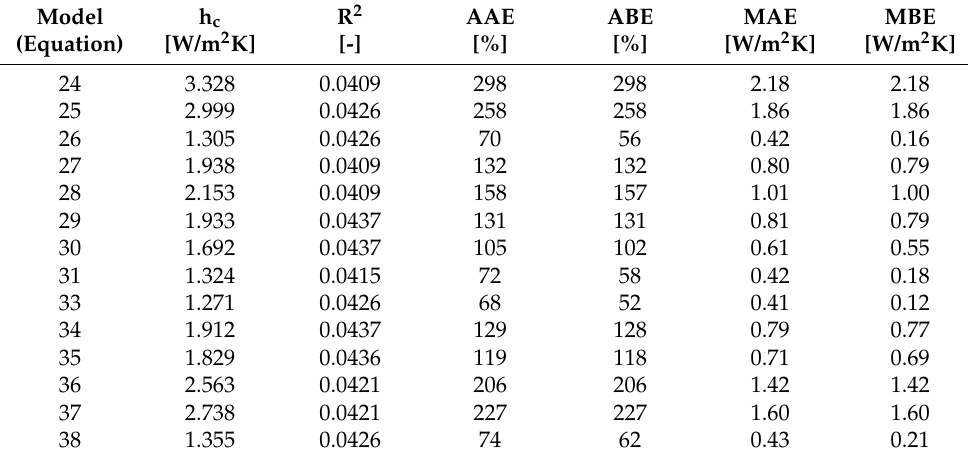
Table 4. Convective heat transfer coefficients from presented models and coefficients of the determi- nation referred to measured